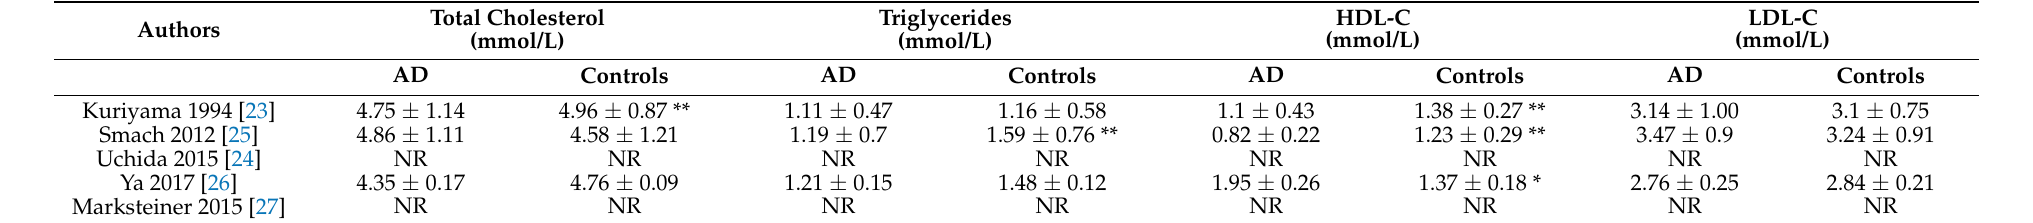
Table 2. Lipid profile of the population